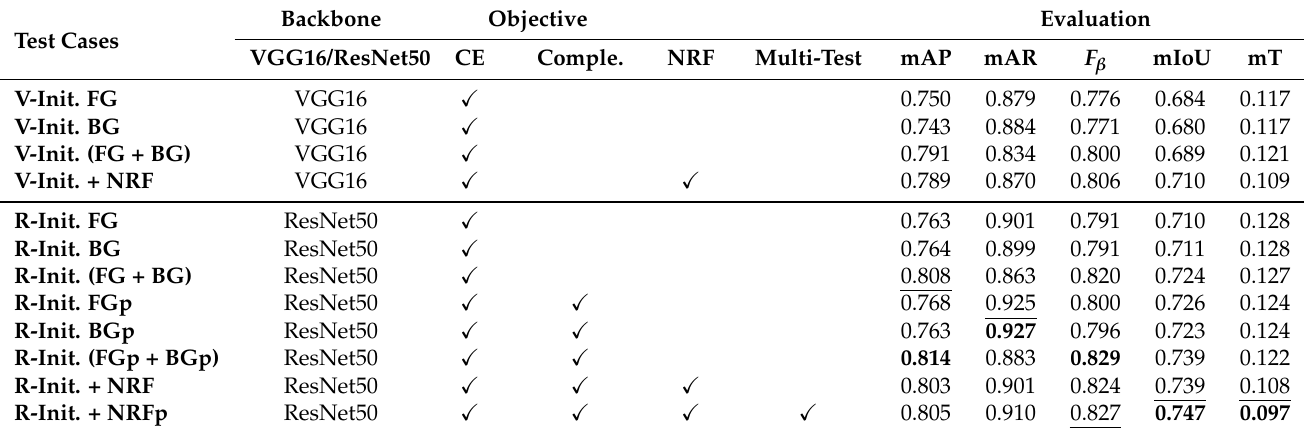
Table 3. Detailed performances of our approaches. The first test group is our previous work in [39], and the second group is our current work. V-Init/R-Init.: corresponding results initialized by previous/current network. FG (FGp)/BG (BGp): foreground/background estimation with (without) the constraint of complementary loss. NRF (NRFp): neighborhood reversible flow (with